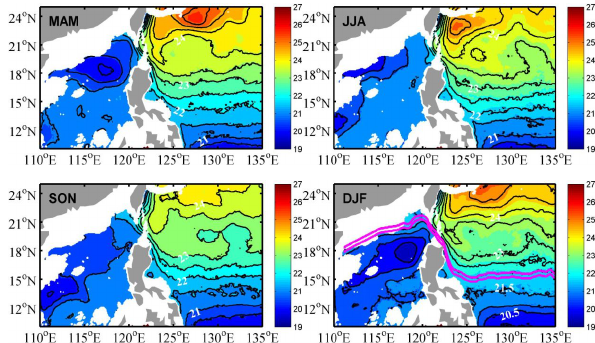
Figure 5. Seasonal acceleration potential (m 2 s − 2 ) averaged be- tween 23.5 and 25.5 σ θ